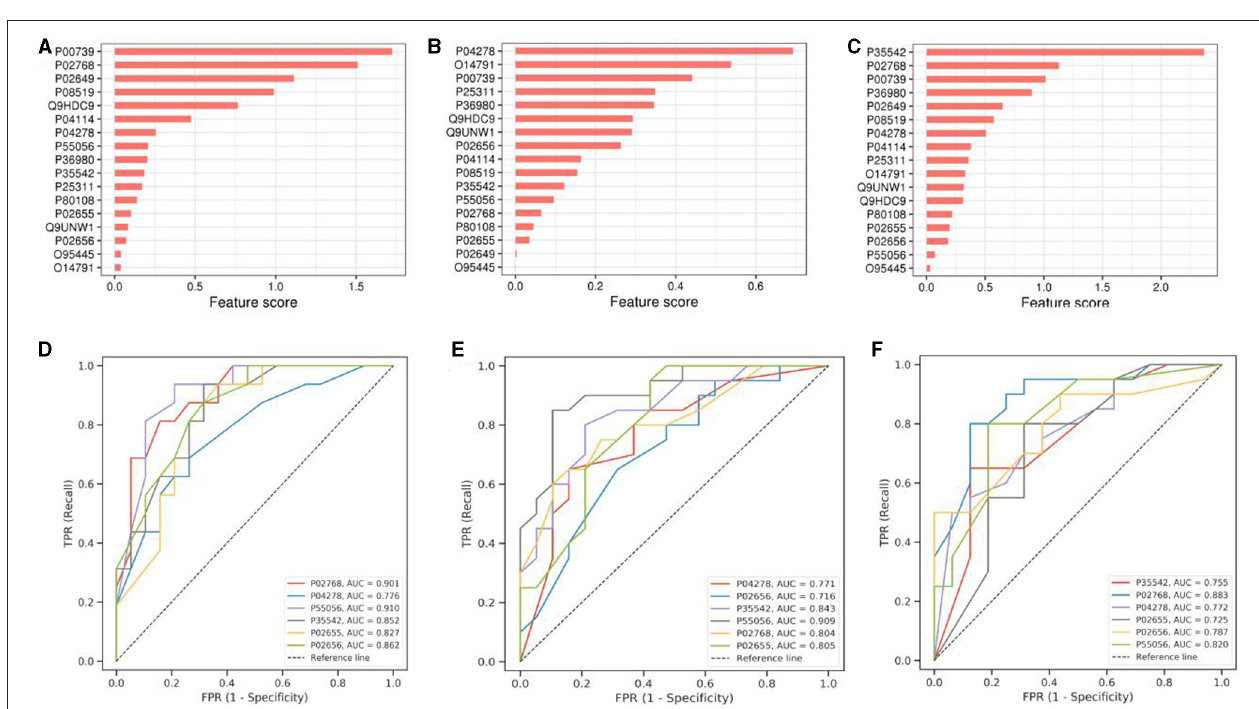
FIGURE 3 | Heatmap results of PRM. The 1, 2, and 3 in the horizontal coordinates represent C1, T2, and T3, respectively. The darker the Red Module, the higher the expression, and the darker the blue module, the lower the expression. The ordinate represents the name of the protein.